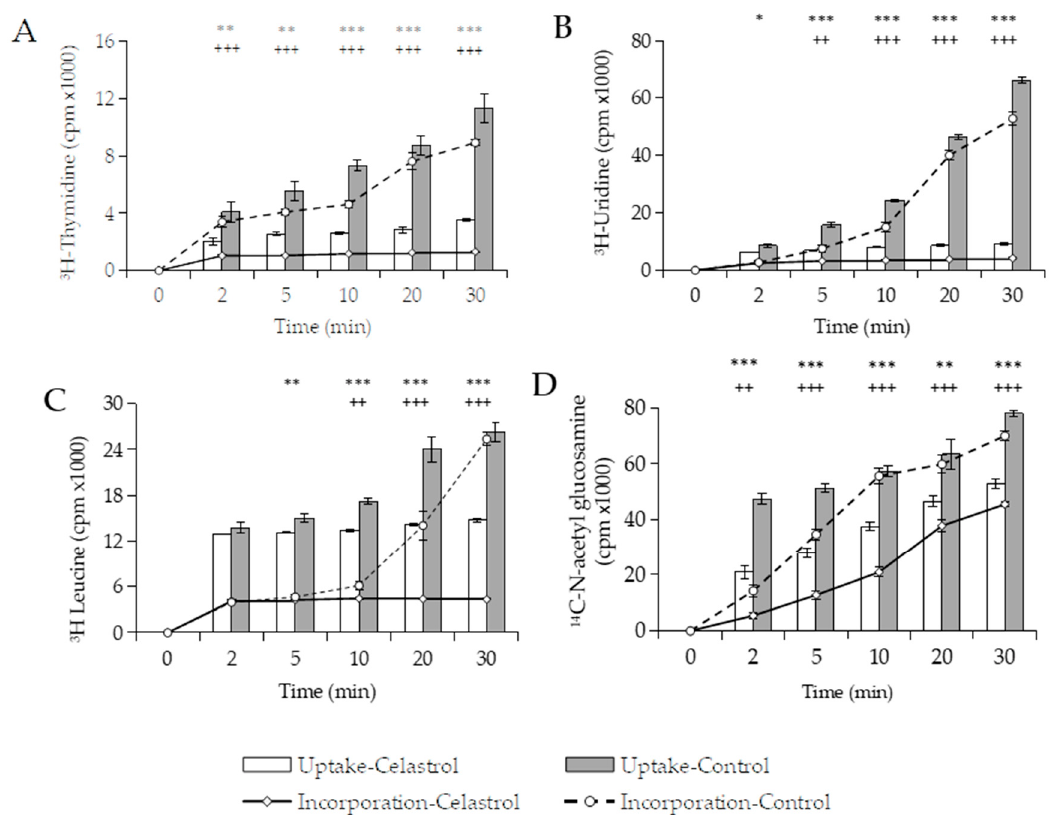
Figure 5. Incorporation (insoluble phase) and uptake (soluble phase) of DNA ( A ), RNA ( B ), protein ( C ), and cell wall ( D ) precursors on B. subtilis cultures in the presence of celastrol (3 µg/mL). Cultures in the same conditions but without celastrol and with the same proportion of DMSO were used as negative control. Error bars express SD with n = 3. Significant differences found in uptake (***: p < 0.001. **: p < 0.01. *: p < 0.05) or incorporation (+++: p < 0.001. ++: p < 0.01) compared with control (one-way ANOVA; Tukey’s test).